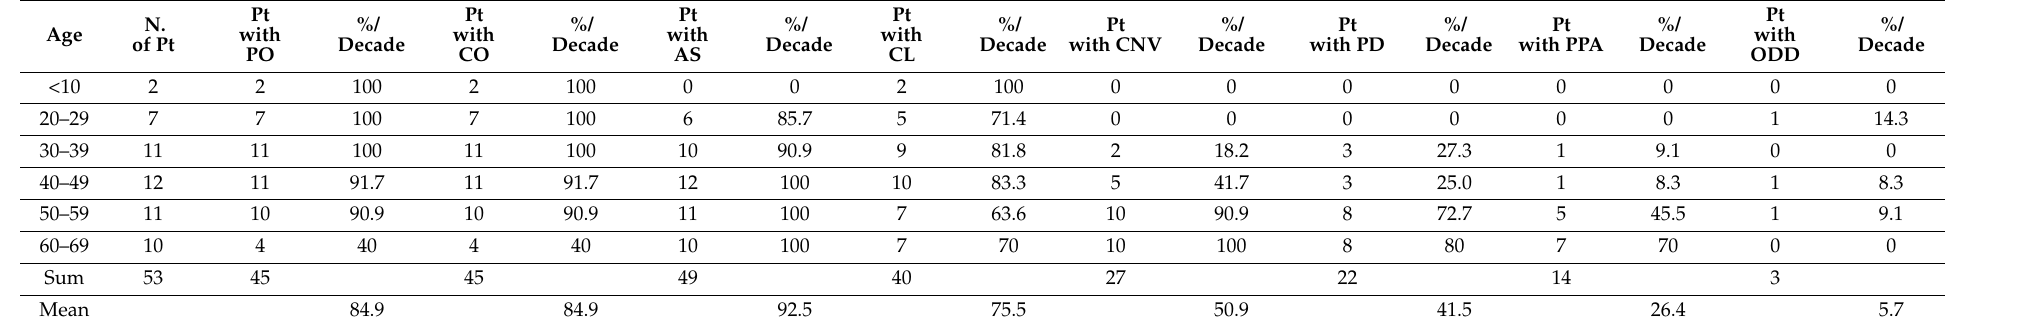
Table 2. Ocular manifestations found in PXE patients (pt) in different age